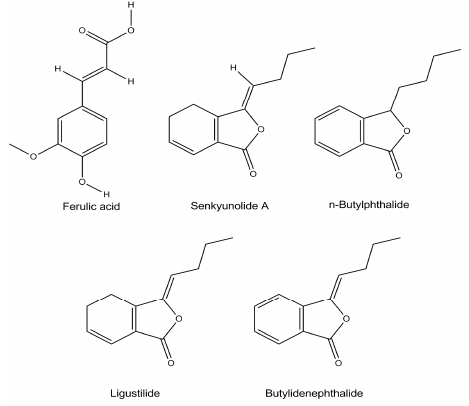
Figure 6. Chemical structures of ferulic acid and